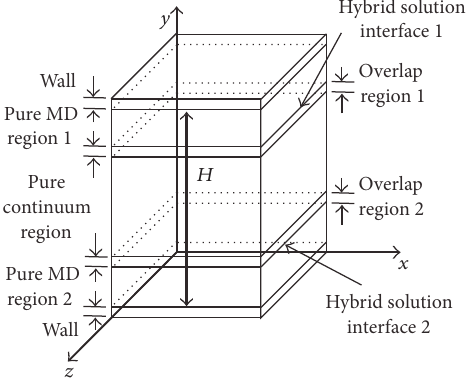
Figure 1: Simulation domain decomposition and coordinates of the no-slip boundary condition; 𝐻 is the height of the channel.